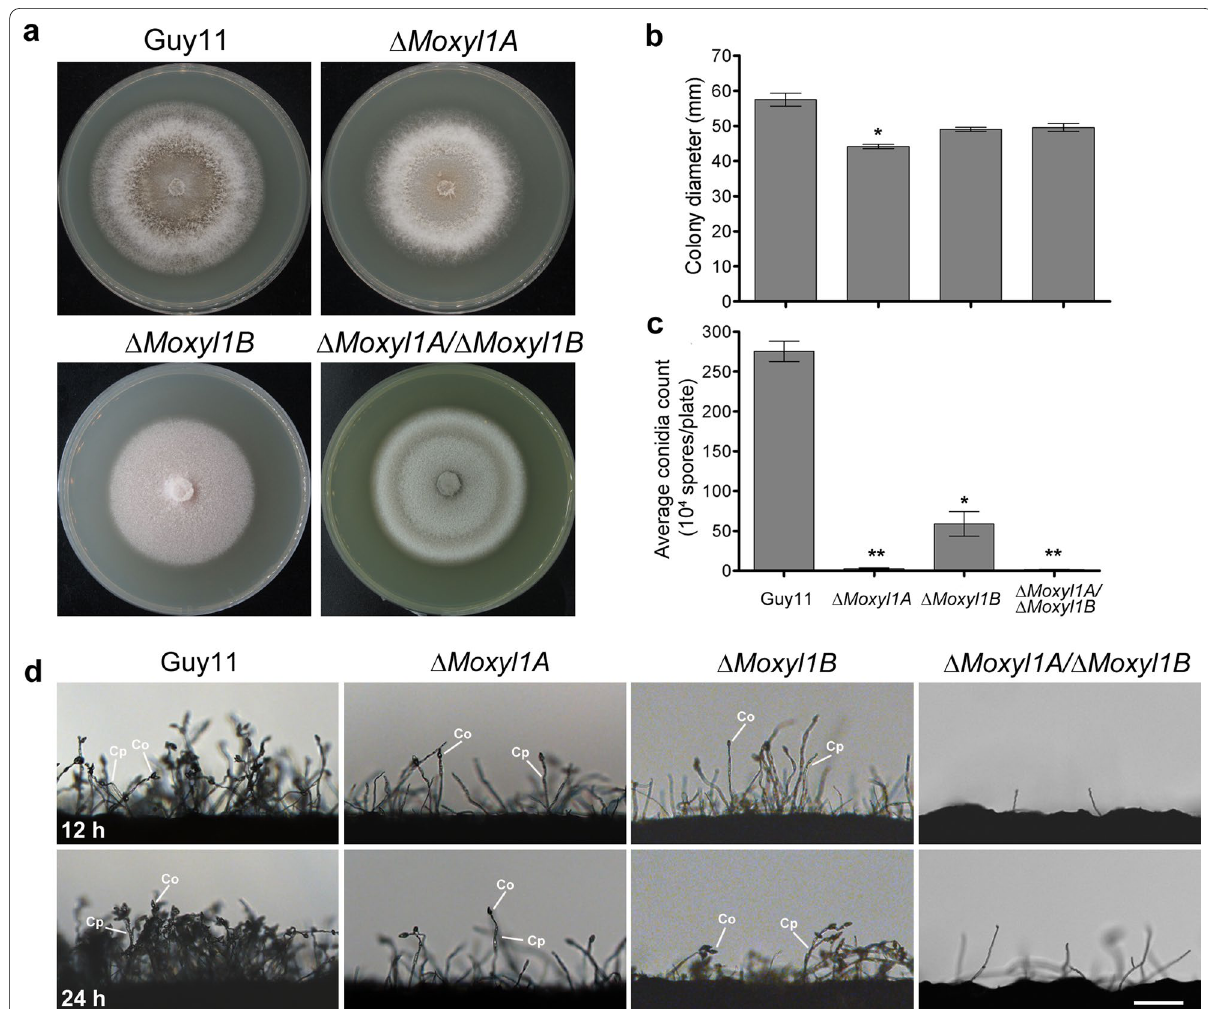
Fig. 1 Impact of MoXYL1 gene deletion on colony morphology and infectious growth of M. oryzae . a Strains of the indicated genotype were inoculated on CM media and photographed after 10-days of growth. b Statistical analysis of average colony diameter (mm) from three independent biological experiments with five replicates each. One-way ANOVA (non-parametric) was employed to assess statistical significance. Error bars account for standard deviation and asterisks represent the significant difference between wild type Guy11 and the mutant strain ( p < 0.001). c Depicts drastically reduced ability of conidiophoregenesis of Δ Moxyl1A genes as compared to Guy11 at 12 h and 24 h interval. d Quantitation and statistical analysis of conidia production in Δ Moxyl1 strains relative to Guy11, obtained from cultures grown on Rice Bran Media, Straw Decoction and Corn media and CM-II media, respectively, from five independent biological experiments with five replicates. The data was analyzed with GraphPad Prism5; error bars represent the standard deviation, while a single asterisk (*) represent significant differences ( p < 0.05) and double asterisks (**) represent significant differences ( p < 0.001) according to ordinary one-way